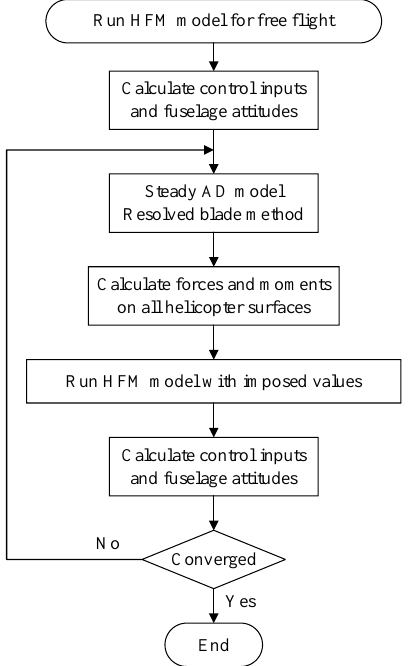
Figure 1. Flowchart of Fully Coupled Simulation of Shipboard Operation.